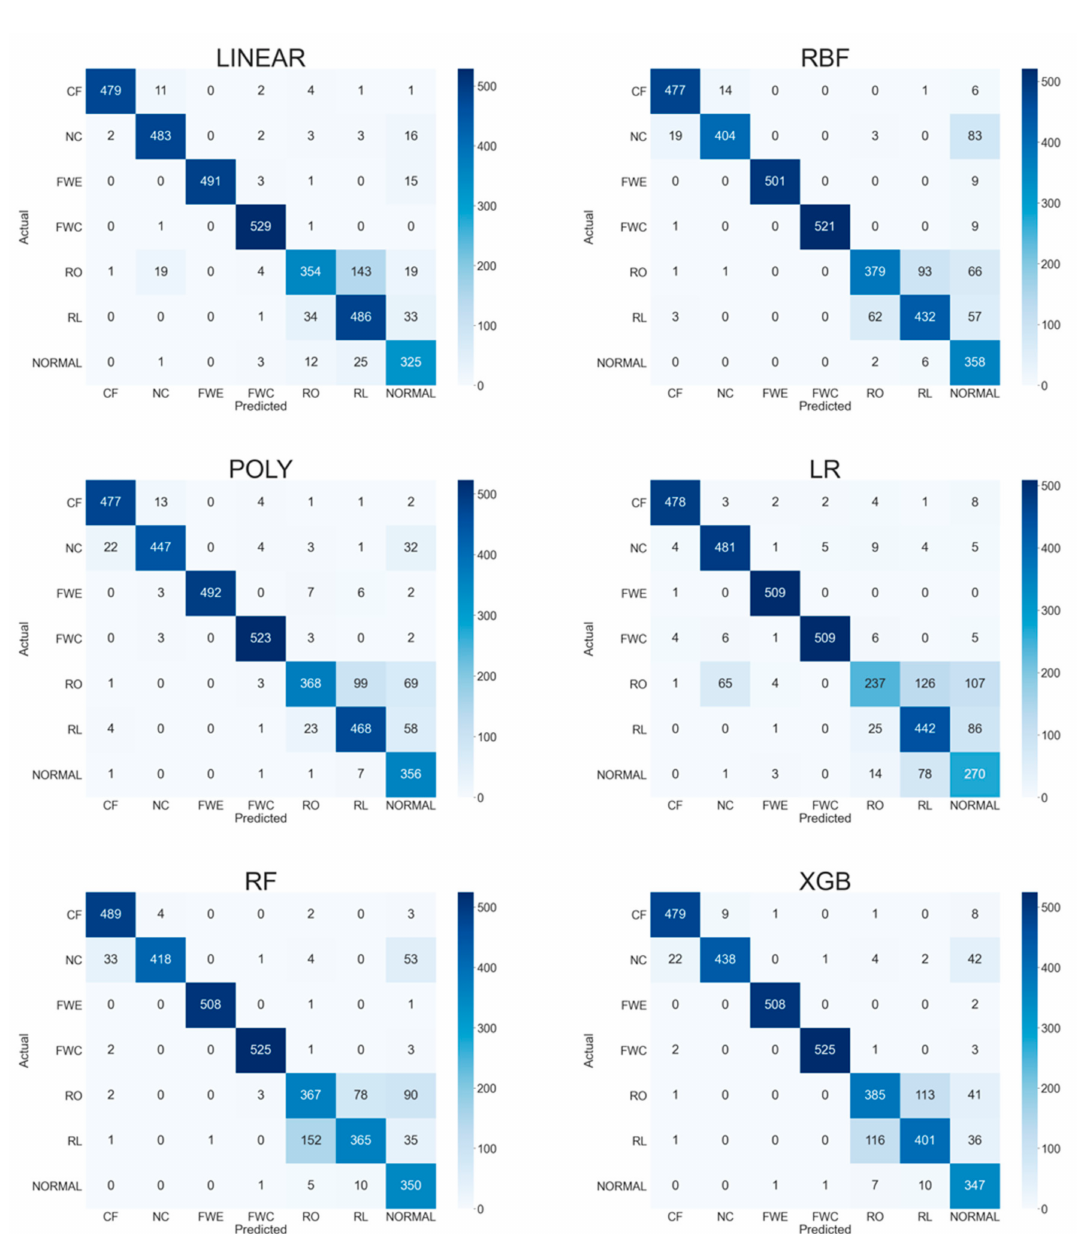
Figure 6. Confusion matrices for parameter-tuned classification methods (Case